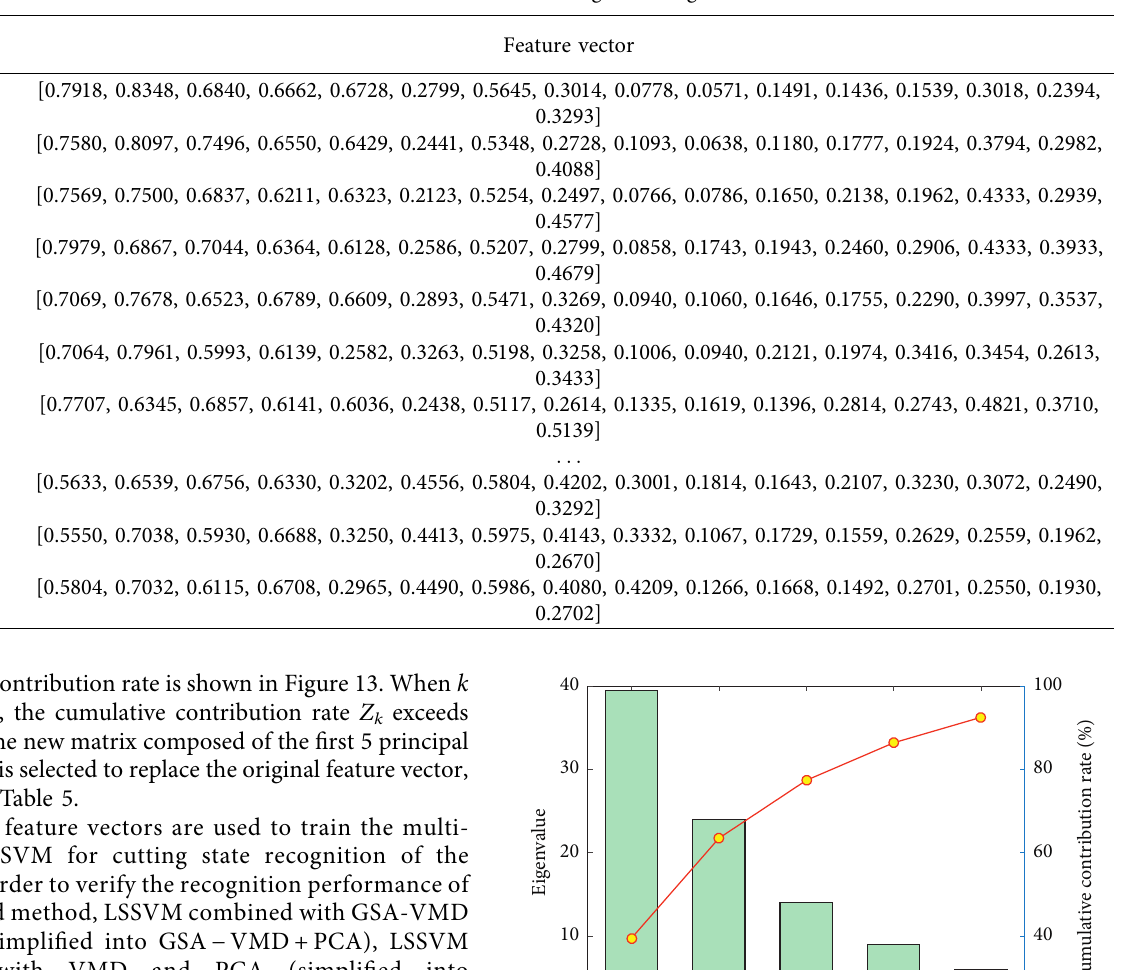
Table 4: The feature vector of cutting sound signal.